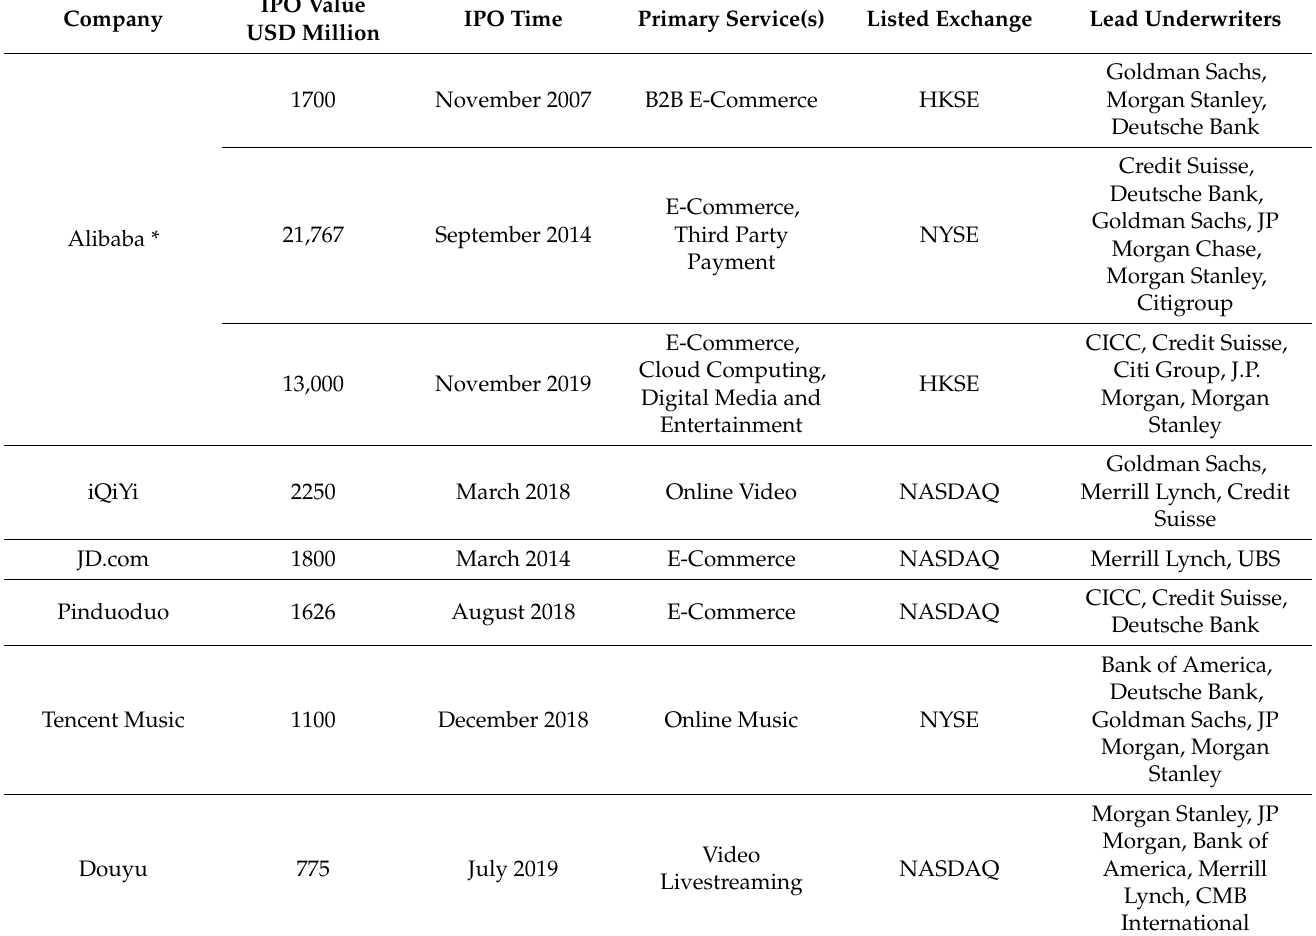
Table 1. Top 21 VIE-structured Chinese Internet Companies that Trade on U.S. and Hong Kong Stock Exchanges with an IPO Value Surpassing USD 100 million before October